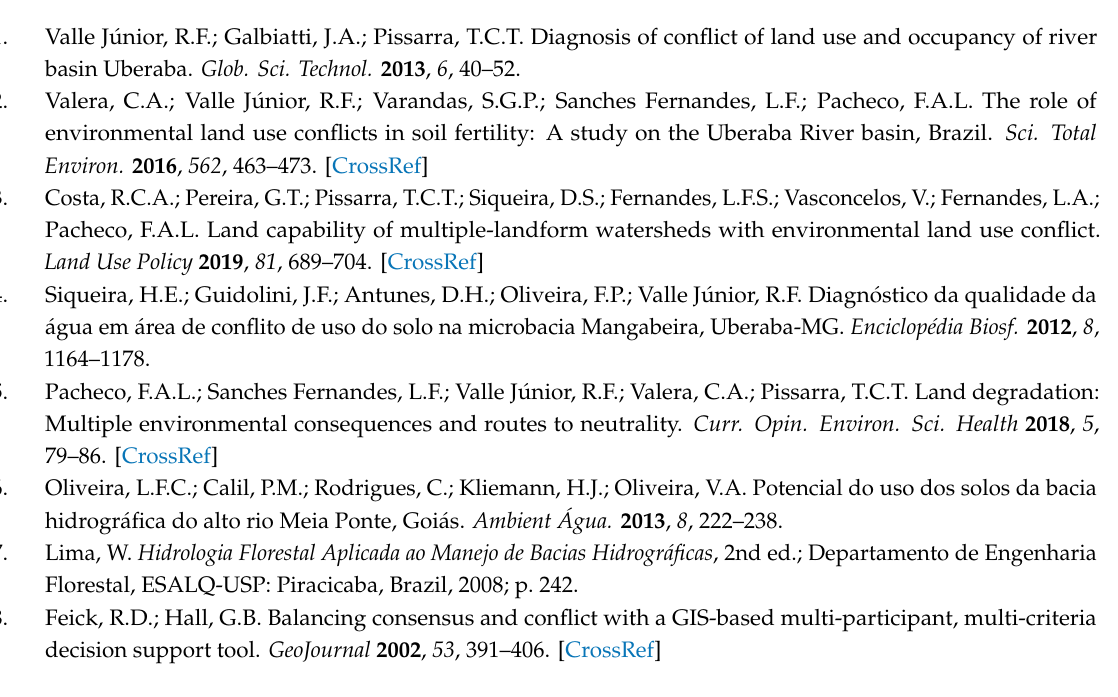
Table S1: Identification of environmental conflicts in Rio Grande